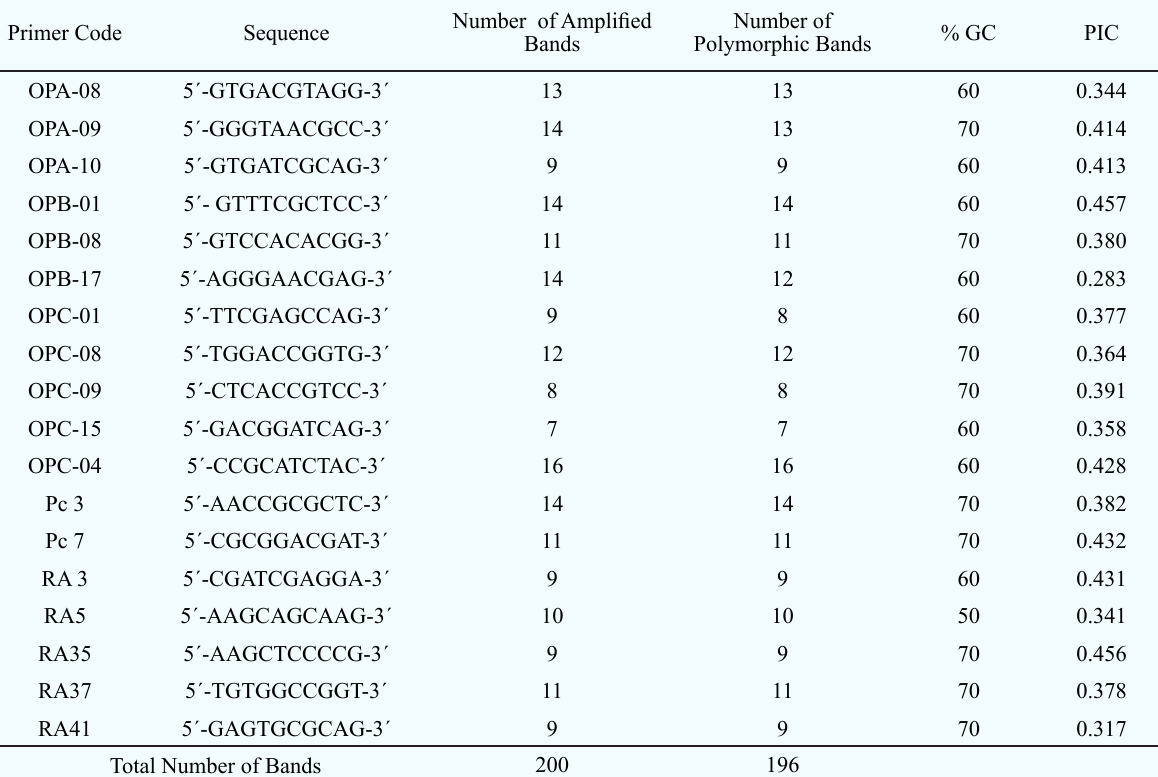
Table 2. Primers and Polymorphic Information